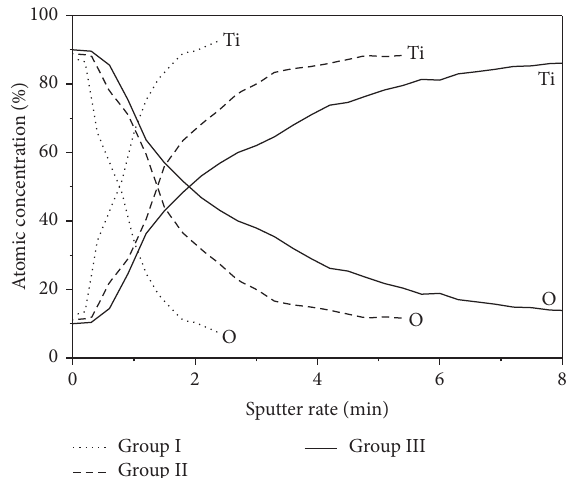
Figure 4: AES elemental deep-analysis spectroscopy.